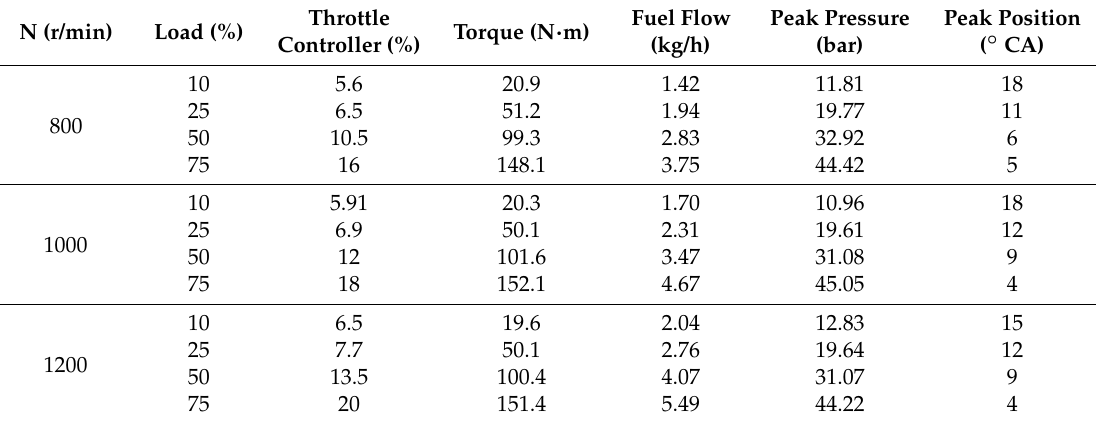
Table 3. Engine operation parameters at different engine working conditions.